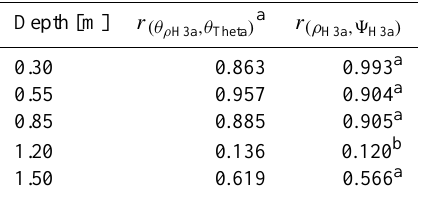
Table 5. Correlation of volumetric water content calculated from resistivity values ( θ ρ H3a ) and water content from soil moisture sen- sors ( θ Theta ) and correlation of resistivity at H3a ( ρ H3a ) and soil suction at H3a ( 9 H3a